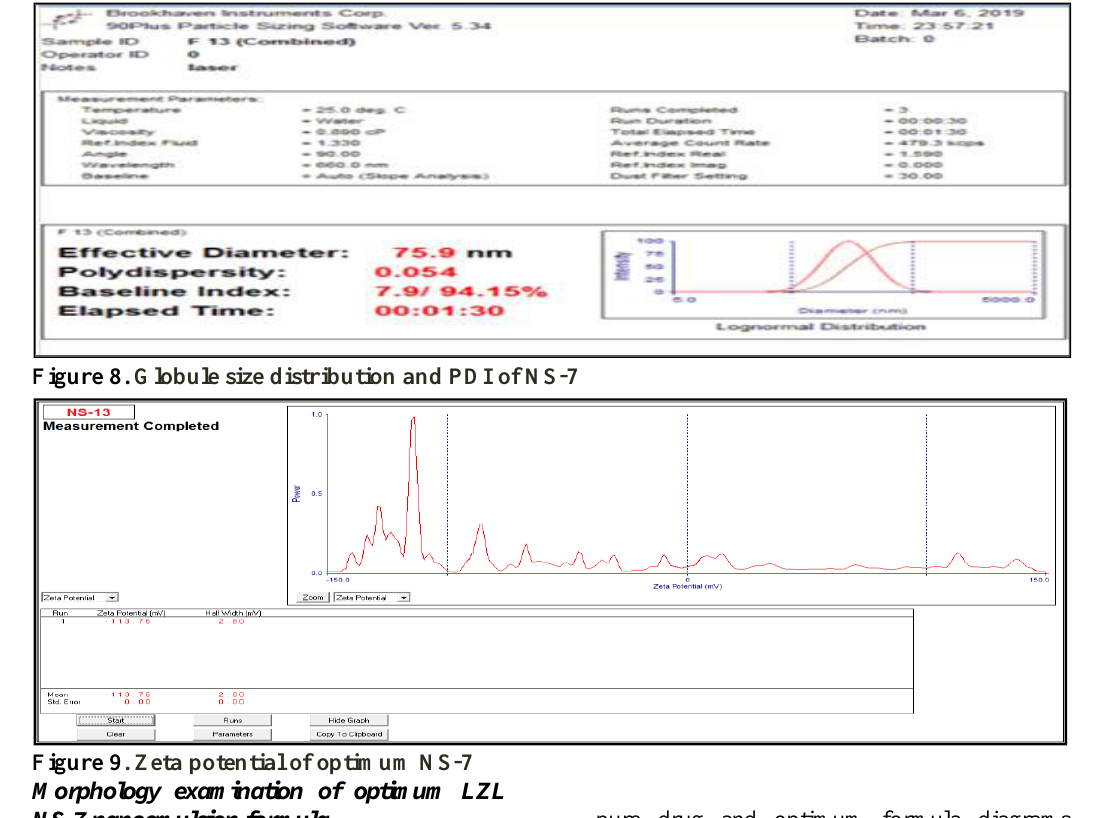
Figure 8. Globule size distribution and PDI of NS-7